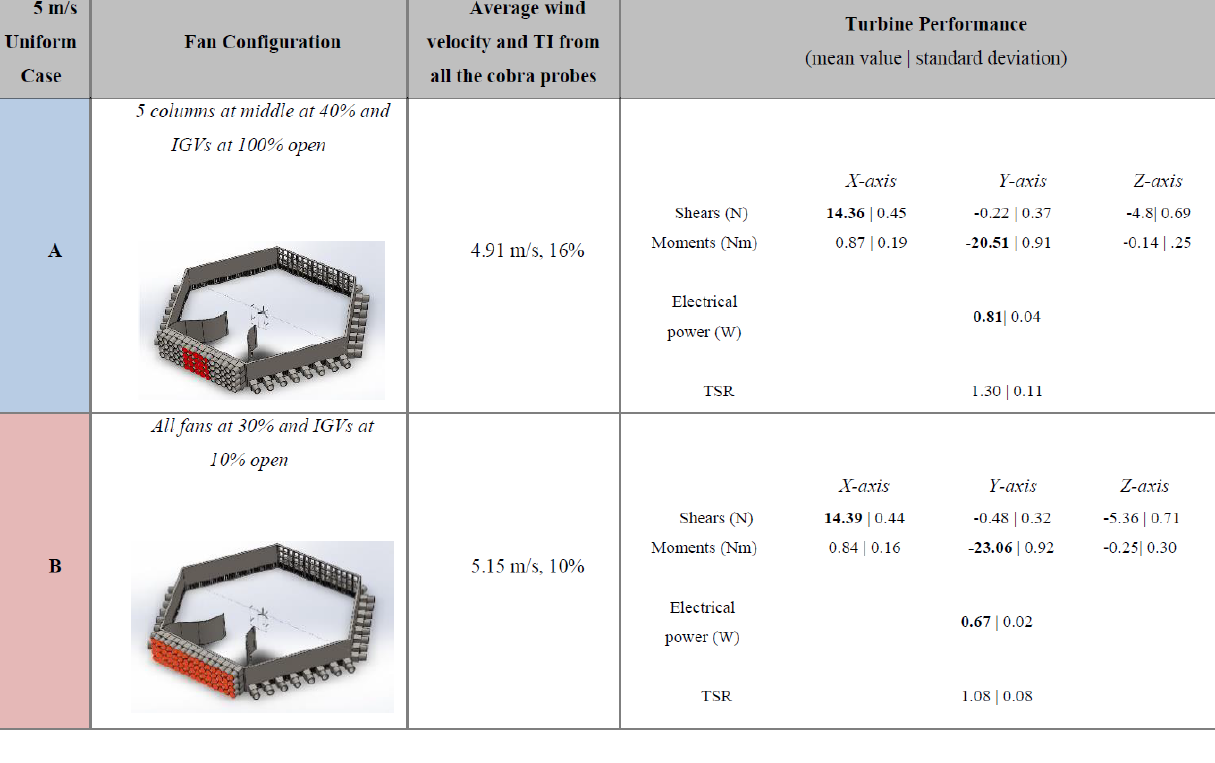
Table 2. Nominal accuracy for the JR3 (75E20S4-6000N) in each axis based on the data